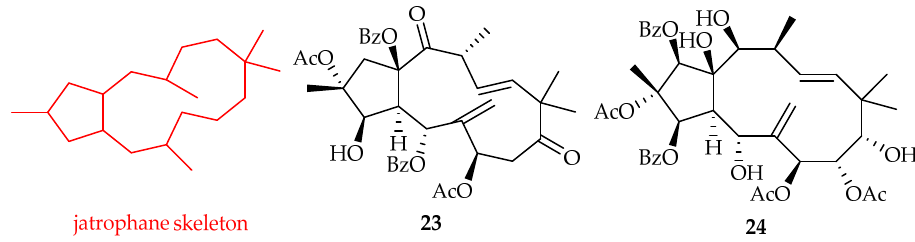
Figure 10. Structures of jatrophane skeleton, compound 23 [21], and euphodeflexin A 24 [20].